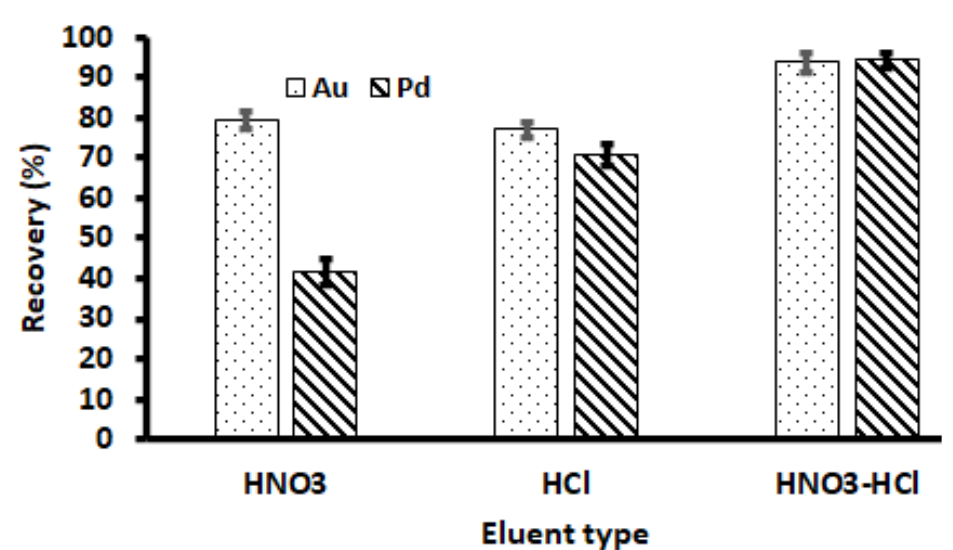
Figure 8. Selection of eluent type. Experimental conditions: mass of adsorbent, 100 mg; eluent concentration, 2 mol L −1 ; initial concentration, 500 µg L −1 ; eluent volume, 10 mL; extraction time, 20 min; desorption time, 5 min; sample pH, 3.5; sample volume, 25 mL.